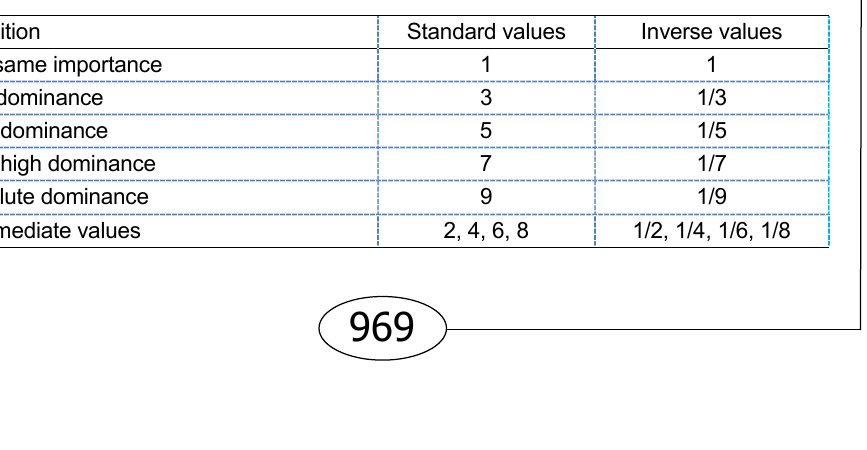
Table 1 – Saaty's scale for comparison in pairs Таблица 1 – Шкала Саати парных